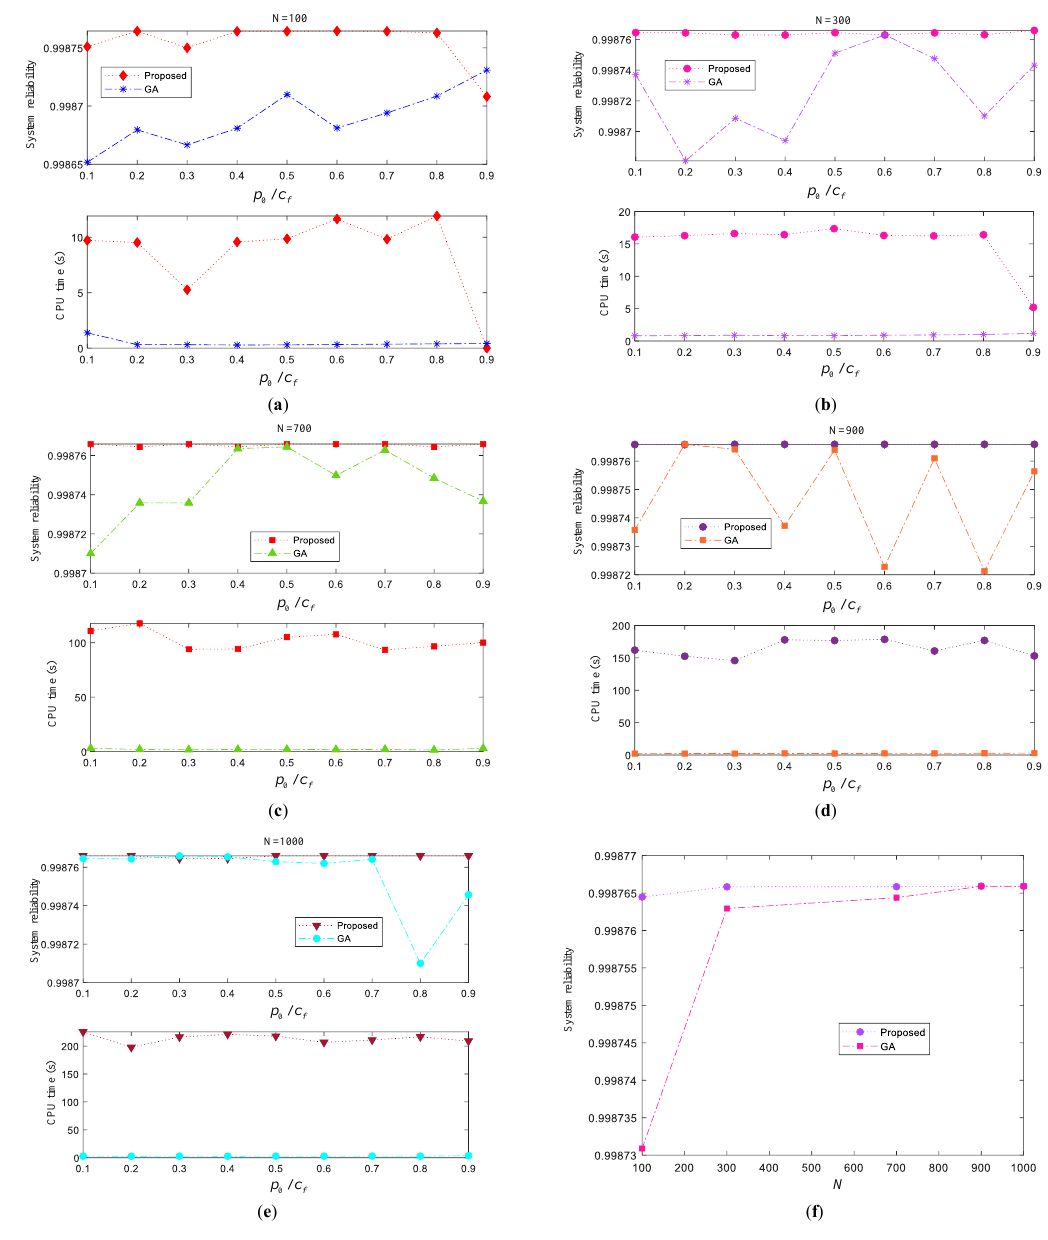
Figure 10. Results of example 4.1. Results of the Lin/Con/2/10:F system. ( a ) Results under N = 100; ( b ) Results under N = 300; ( c ) Results under N = 700; ( d ) Results under N = 900; ( e ) Results under N = 1000; ( f ) Optimal system reliability under different N